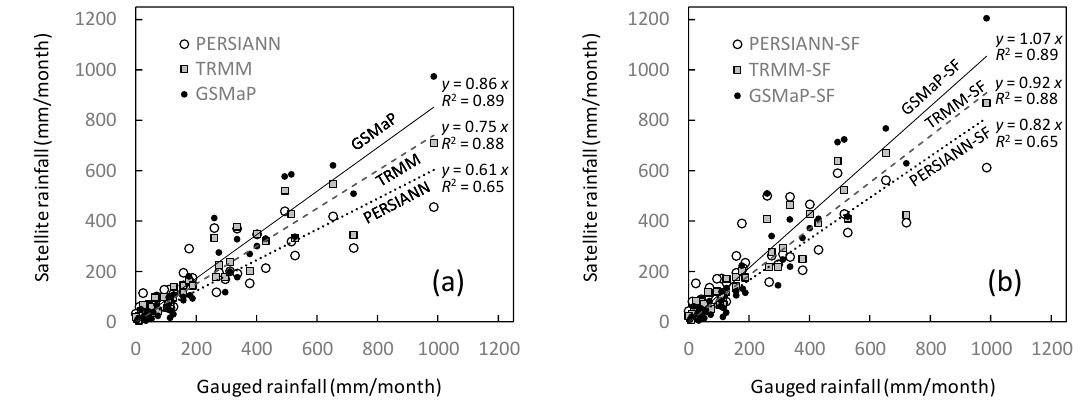
Figure 4. Comparison of monthly rainfall amounts of the SREs to Gauged-R data; ( a ) raw data; ( b ) data corrected by the scale factors.